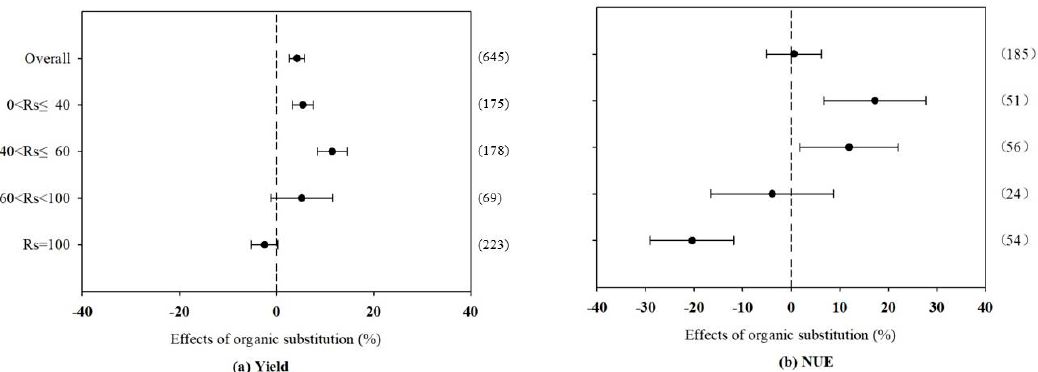
Figure 4. Effects of four rates of organic fertilizer substitution on maize yield ( a ) and nitrogen use efficiency (NUE) ( b ). Rs, substitution rate, defined as organic nitrogen (N) input/total N applied (%). Error bars represent 95% confidence intervals. Numbers in parentheses indicate the numbers of observations.